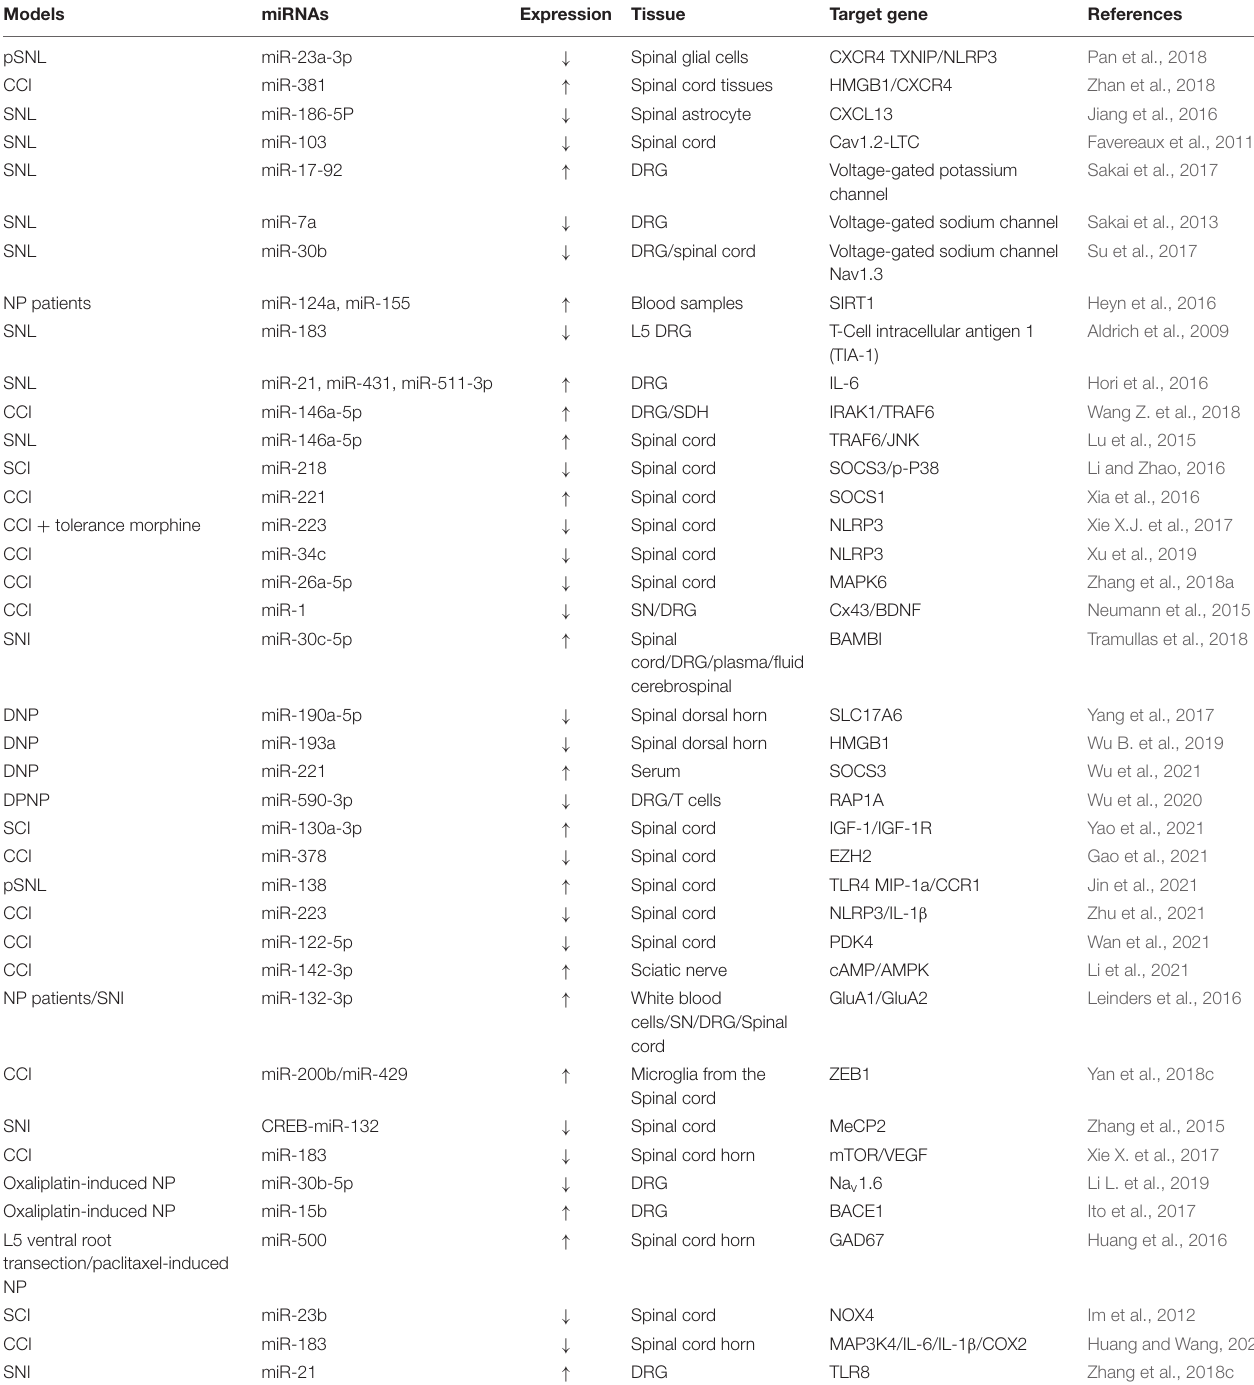
TABLE 1 | miRNAs associated with neuropathic pain.